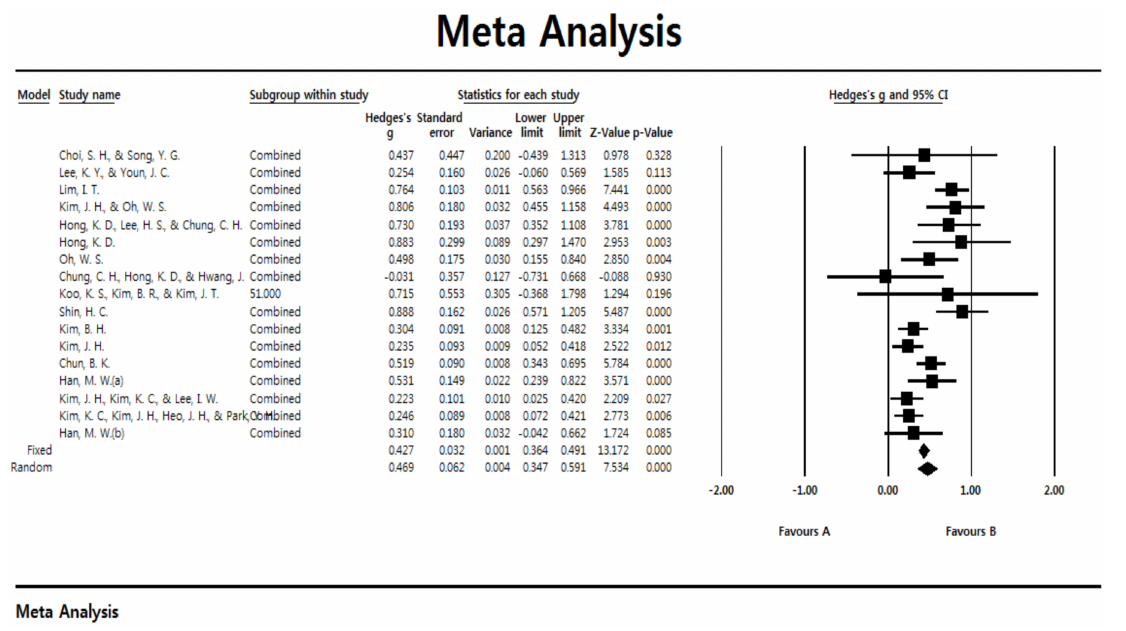
Figure 2. Forest plot of the summary statistics.